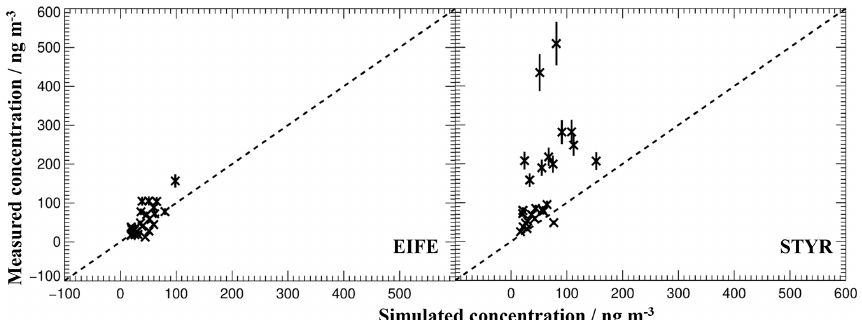
Figure 4. Comparison between observed and simulated levoglucosan concentration at the EIFE and STYR sites. Also, the 1:1 line is given (dashed